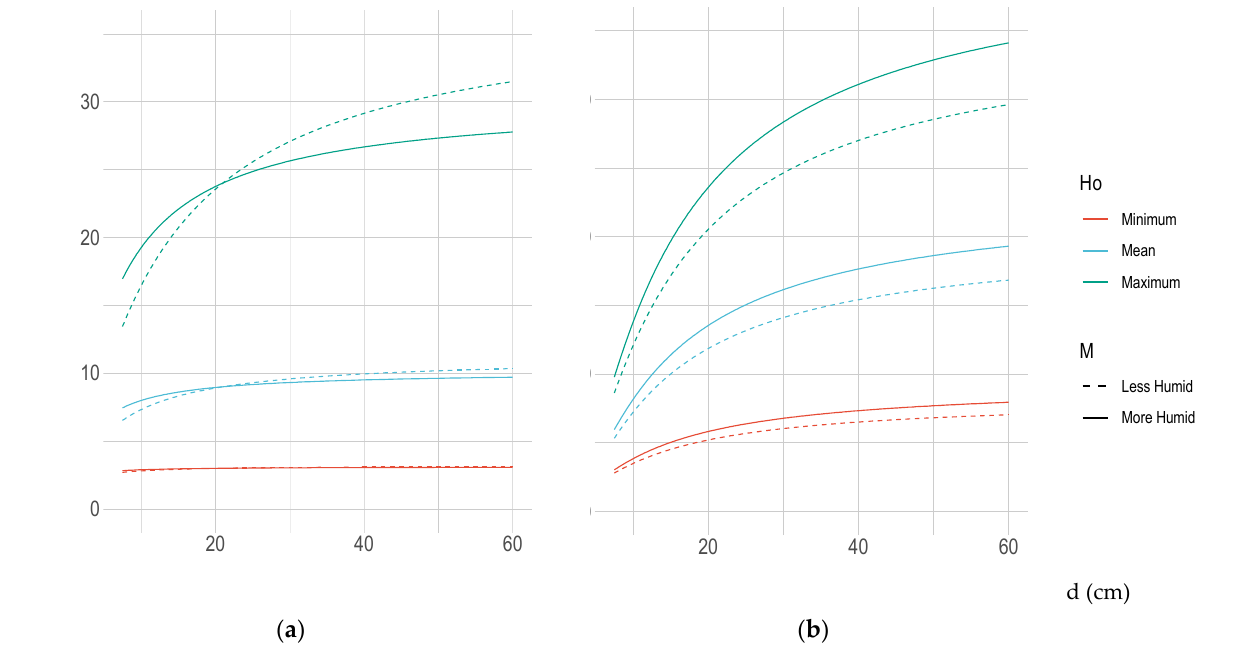
Figure 3. Aridity influence in terms of the De Martonne Index (M), on H–D relationship for different stand dominant height (Ho) in ( a ) Pinus halepensis mixed with Quercus ilex and ( b ) Quercus robur mixed with Fagus sylvatica , depending on parameter significance from selected H–D models. Diameter at breast height (d, in centimeters) is represented in x -axis, since total tree height (h, in meters) is represented in y -axis.